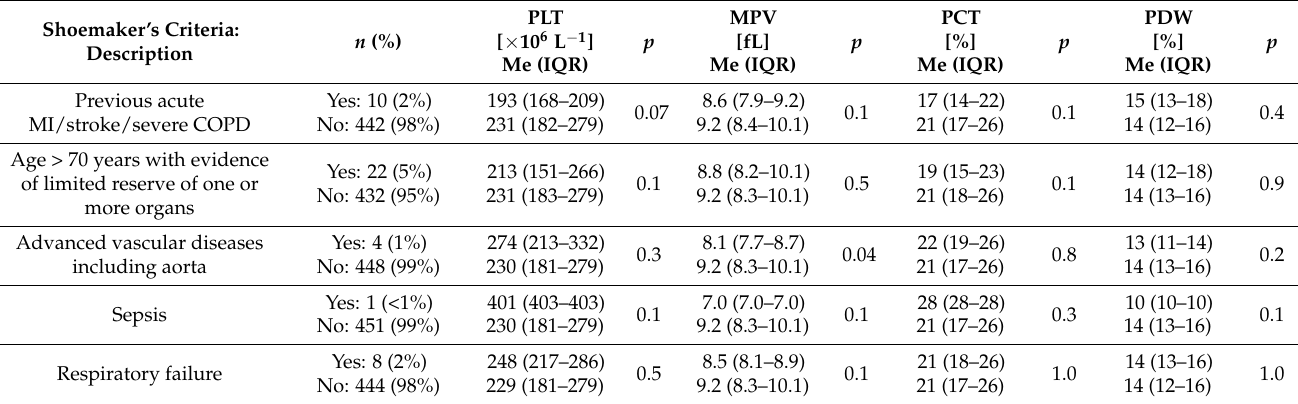
Table 3. Values of platelet parameters and Shoemaker’s criteria.